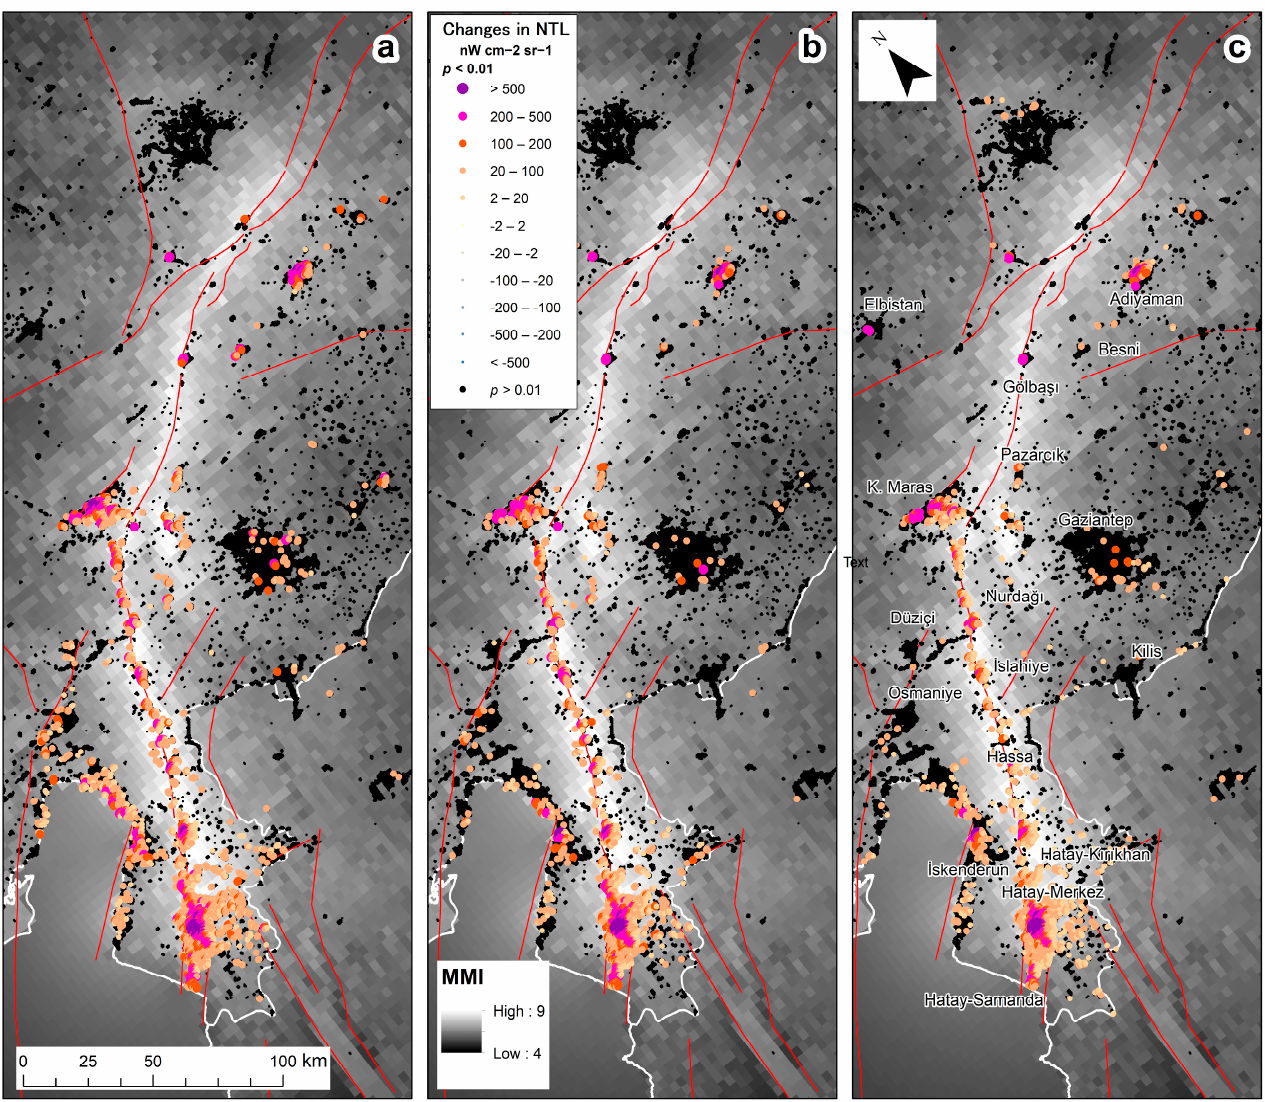
Figure 5. Statistically significant changes in NTL ( p < 0.01), comparing the 36 days before the 6 February earthquakes, and selected periods after the 6 February earthquakes: ( a ) 3 days, ( b ) 7 days, ( c ) 14 days. Positive values of NTL changes signify a decrease in NTL. Very few areas with statistically significant changes in NTL were found outside of the area shown on the map. Black dots represent VIIRS lit grid cells, where no statistically significant changes in NTL were found. All maps are overlaid by the USGS shakemap of the 7.8 magnitude earthquake (in units of MMI) and by major fault lines.